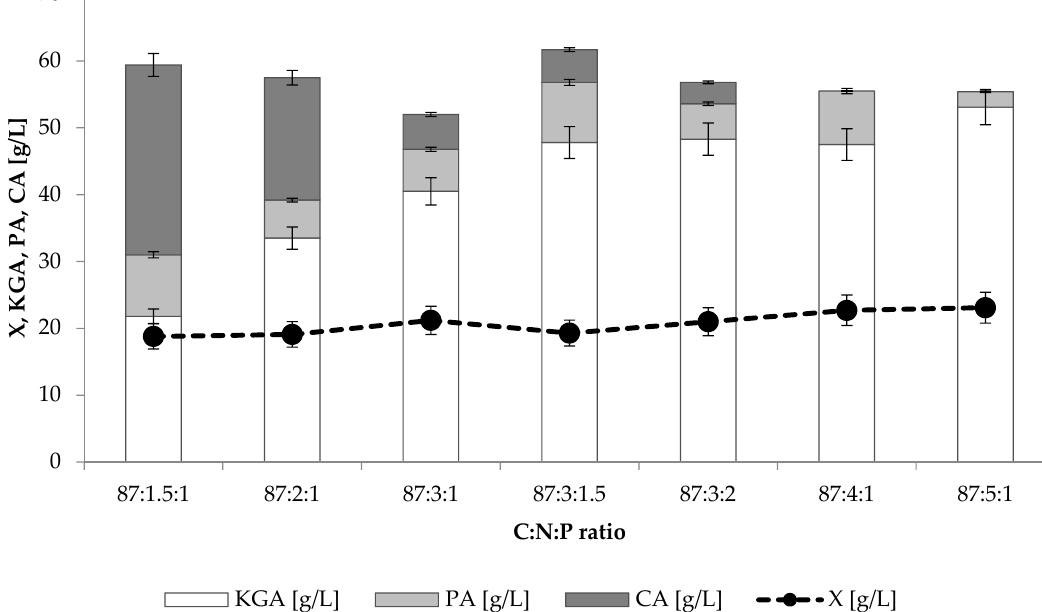
Figure 3. The influence of applied carbon:nitrogen:phosphorus ratio in cultivation media on yeast growth (X) and level of α -ketoglutaric (KGA), pyruvic (PA) and citric (CA) acid production by Y. lipolytica 1.31.GUT1/6.CIT1/3.E34672. Error bars represent the standard deviations of duplicates. Table 2. Comparison of parameters obtained after α -ketoglutaric acid production by Y. lipolytica